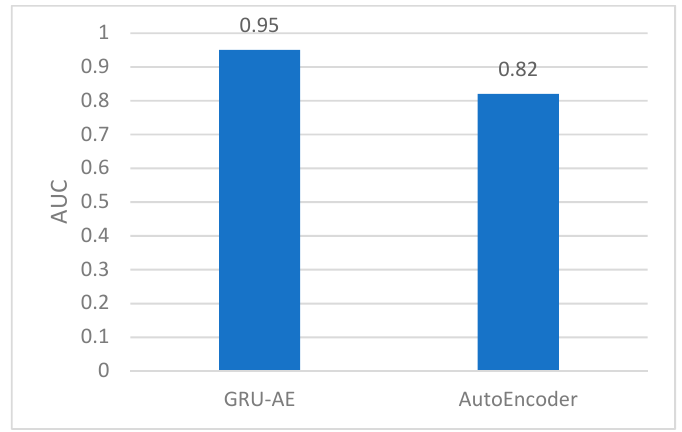
Figure 22. Comparison of AUC .